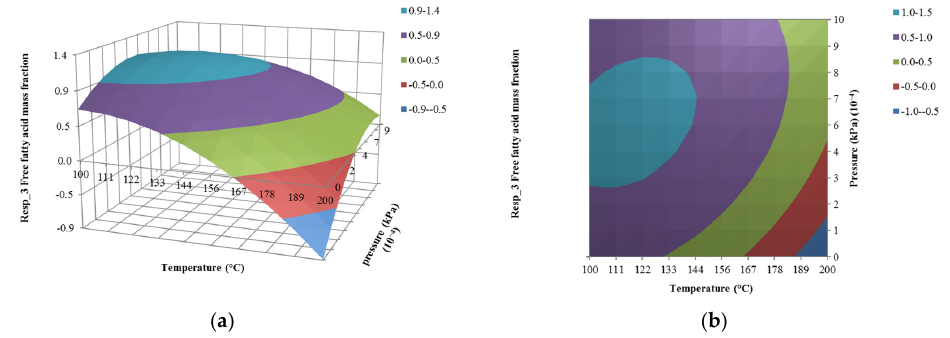
Figure 10. Response surface curve ( a ) and contour plot ( b ) of free fatty acid (FFA) concentration as a function of temperature and pressure.